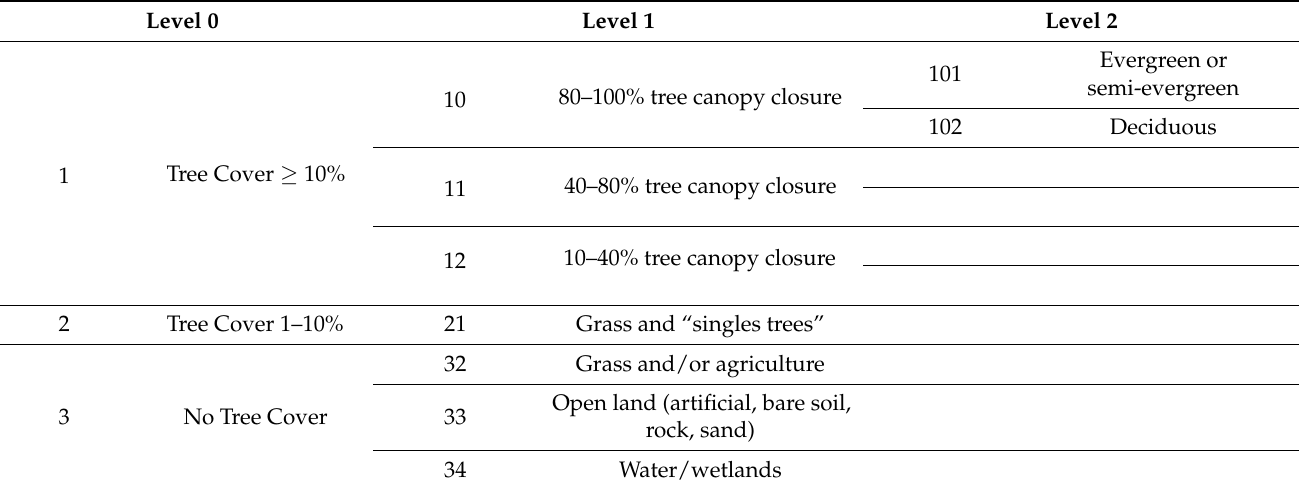
Table 2. Legend for the reference